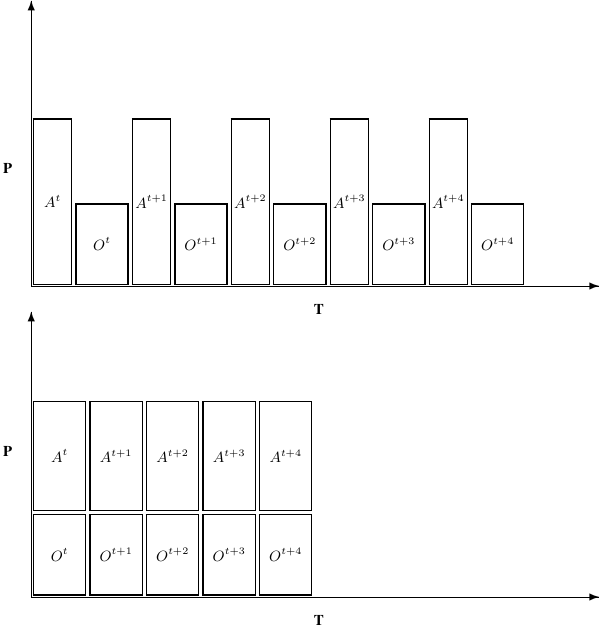
Figure 1. Serial and concurrent coupling sequences, with time on the x axis and processors on the y axis. In the serial case, both com- ponents may not scale to the same processor count, leaving some processors idle. Note that in the concurrent coupling sequence be- low, O t + 1 only has access to the lagged state A t